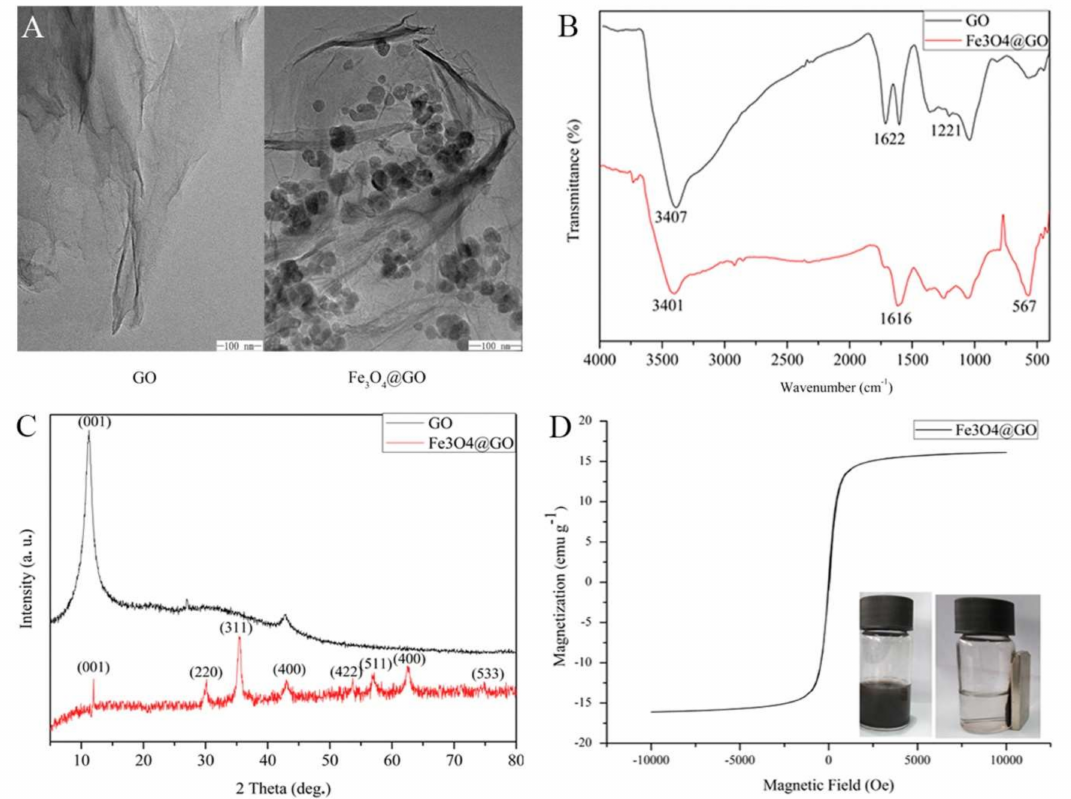
Figure 2. TEM ( a ), FT-IR ( b ), XRD ( c ) and vibrating sample magnetometer (VSM) ( d ) of GO / Fe 3 O 4 . Reproduced with permission from [57]. Copyright Elsevier,